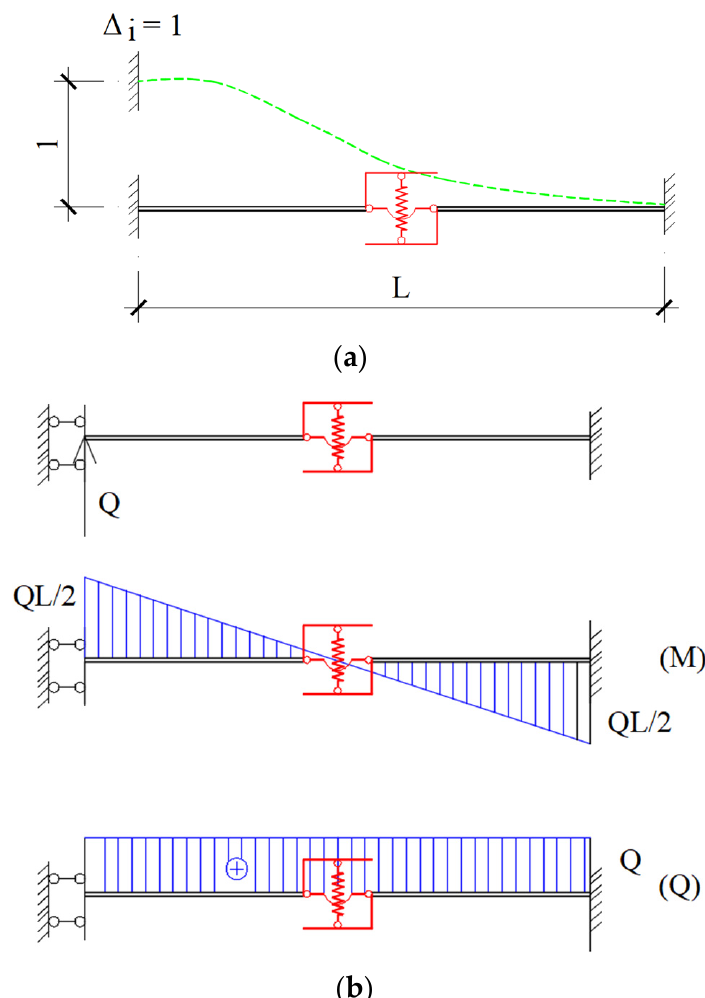
Figure 8. Elements of first column: ( a ) Unit translation at end i; ( b ) Internal force diagrams when unit translation at end i.